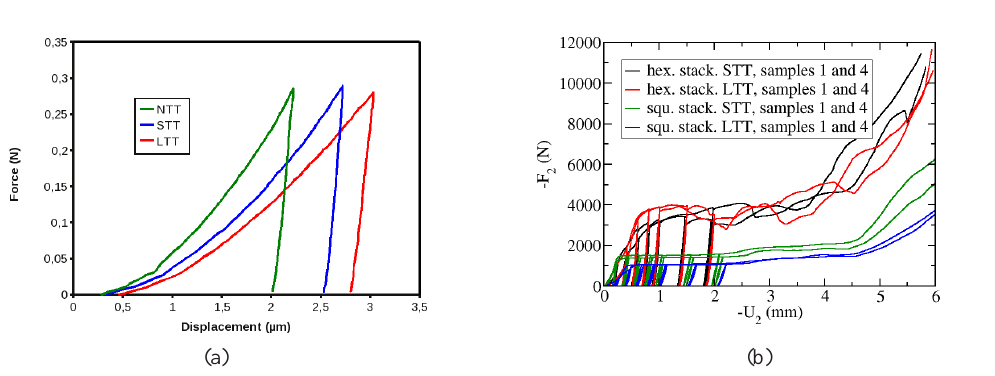
Fig. 4. Influence of the thermal treatment on a) the indentation curves b) the strength of the tube